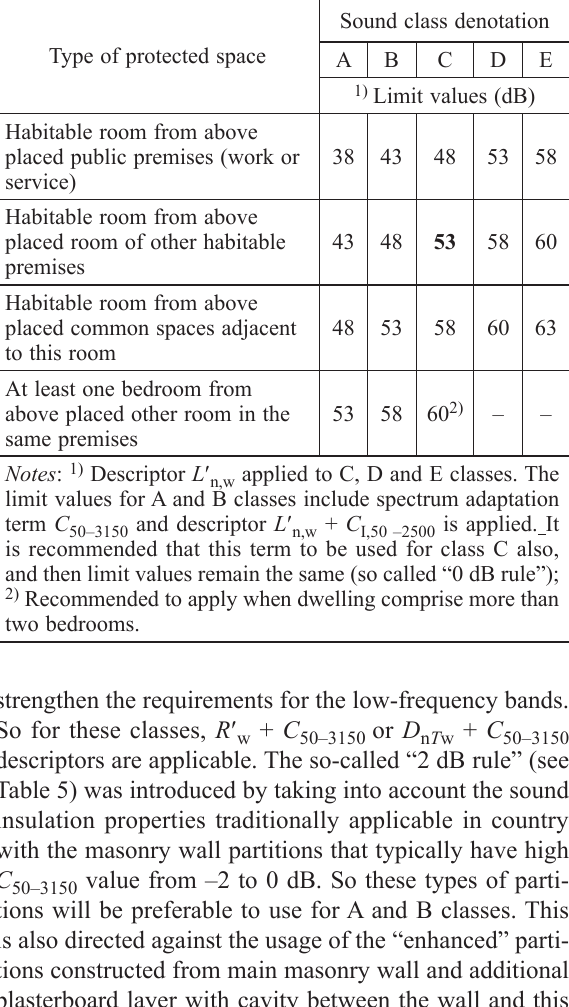
Table 4. The limit values intervals estimated for sound insulation performance of each sound class Acoustic class